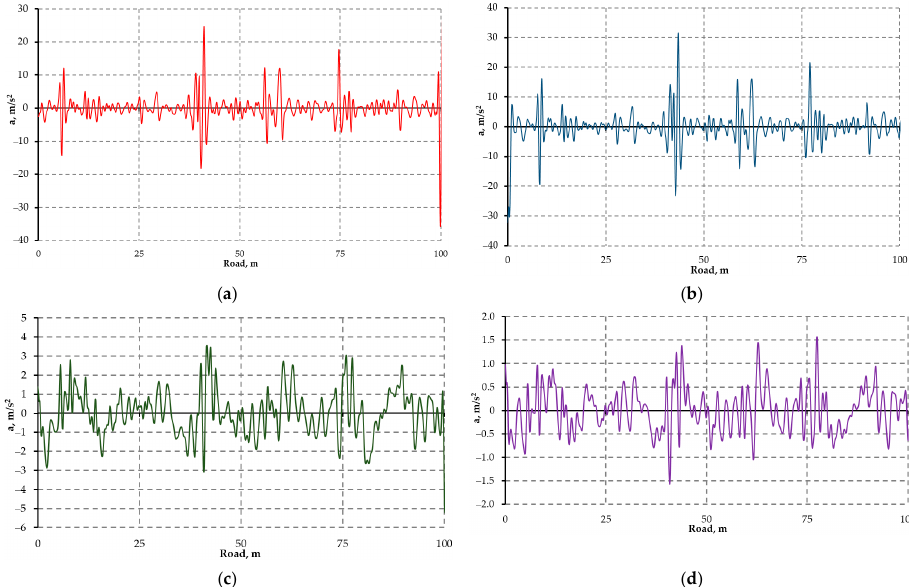
Figure 28. Accelerations of the unsprung ( a , b ) and sprung ( c , d ) masses of compact city measured by modeling on a city-type road at 50 km/h speed: ( a , c )—front and ( b , d )—rear.